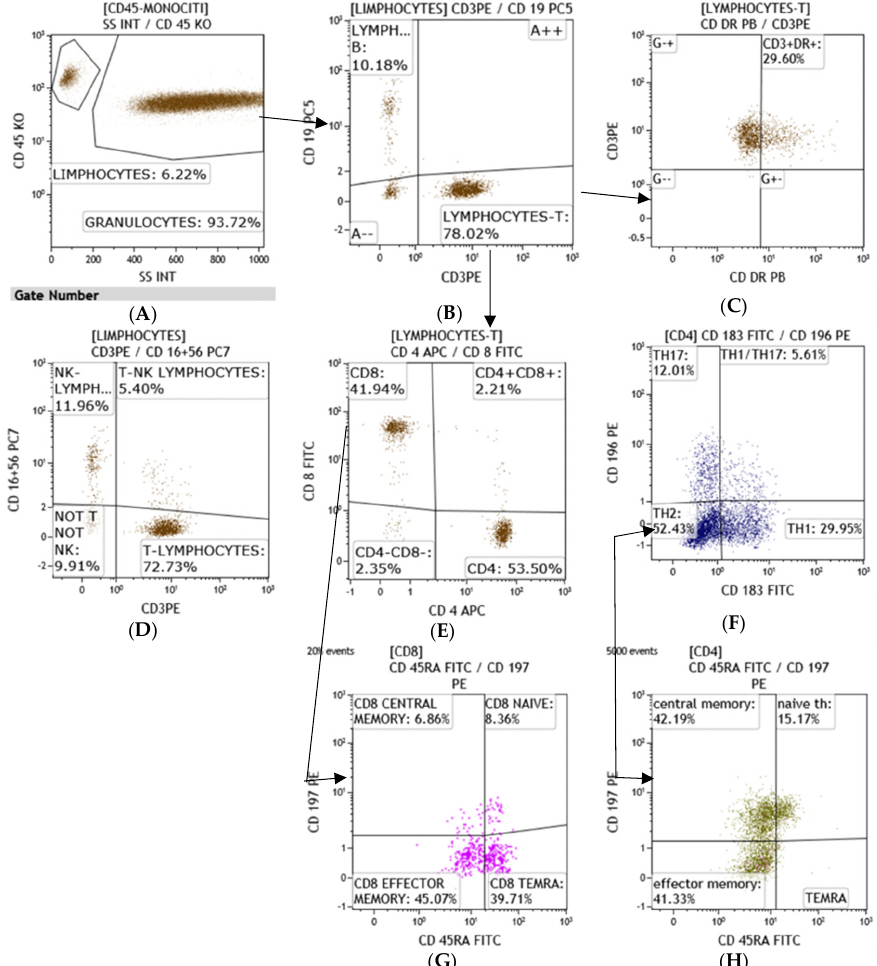
in each dot plot. Clin. Pract. 2021 , 11 , FOR PEER REVIEW